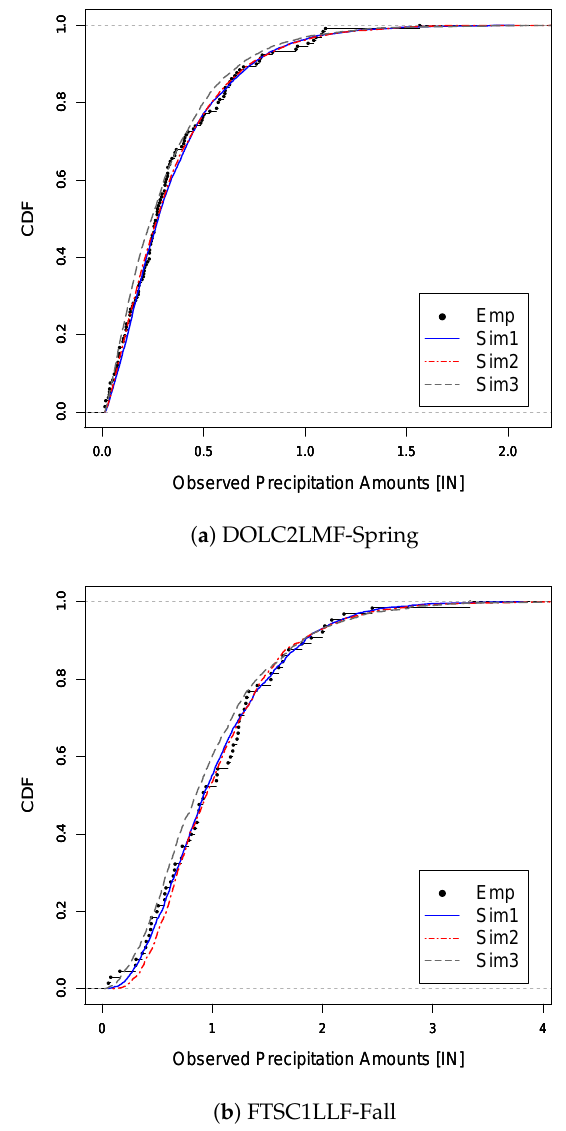
Figure 4. The conditional empirical CDF and its simulated